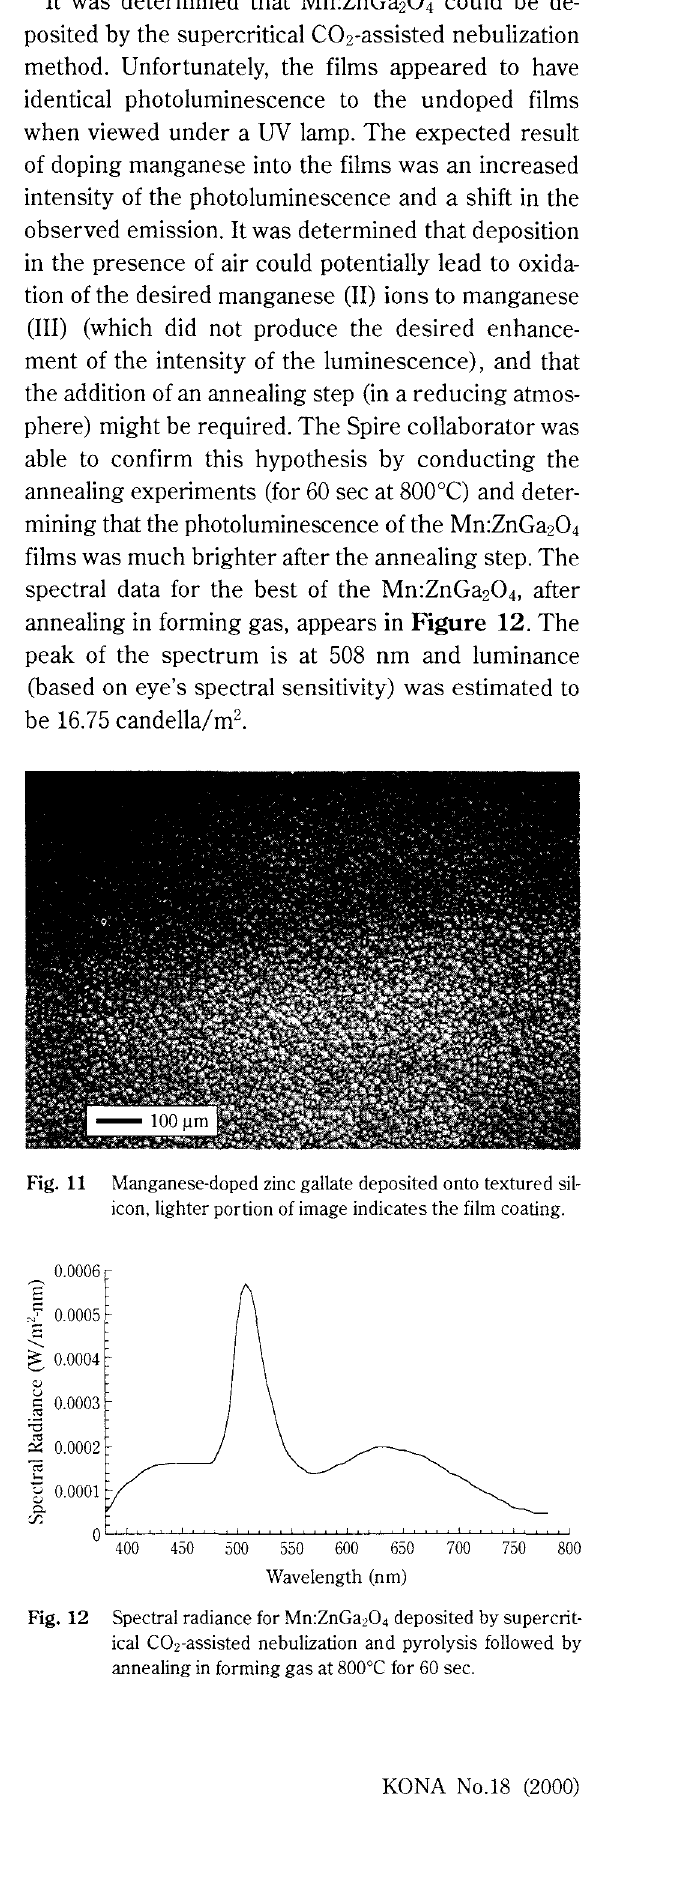
Fig. 12 Spectral radiance for Mn:ZnGa 2 0 4 deposited by supercrit ical C0 2 -assisted nebulization and pyrolysis followed by annealing in forming gas at 800°( for 60 sec.